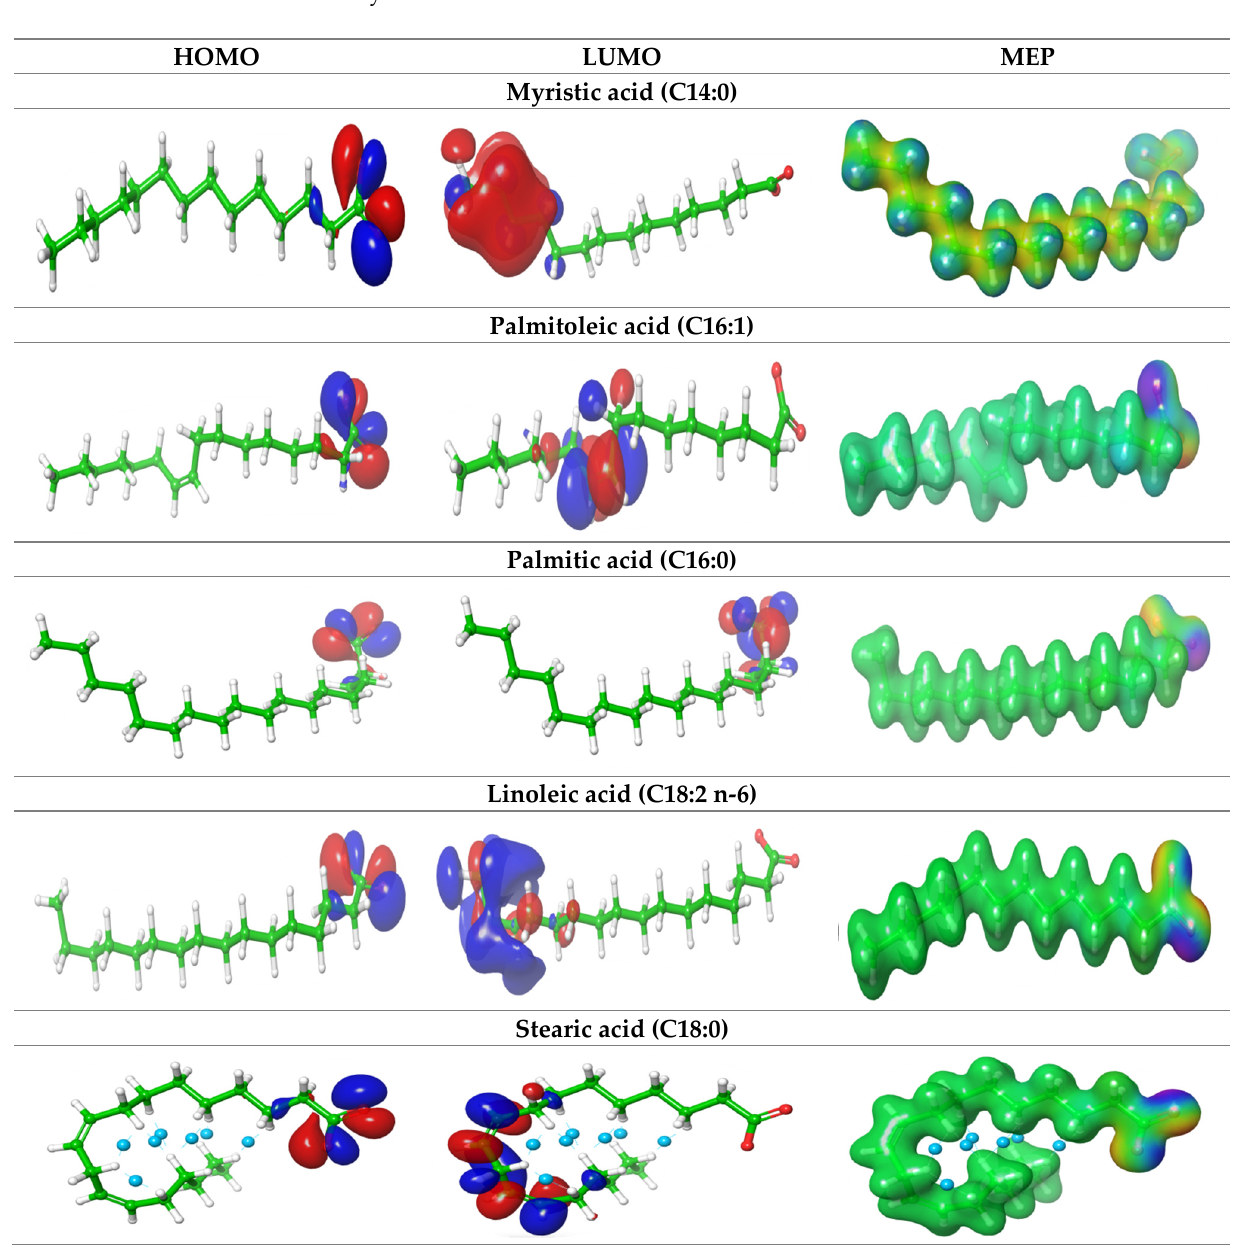
Figure 10. FMOs obtained by DFT/B3YLB/6-311G** for AO and